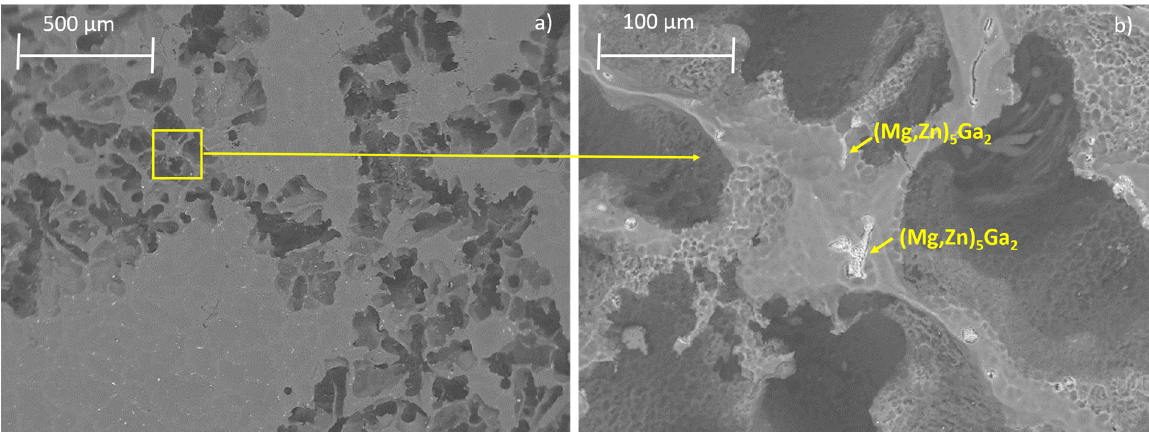
Figure 7. ( a ) Morphology of the as-cast Mg-0.75Ga-3Zn alloy after 168 h of immersion in SBF, after the corrosion products have been removed and ( b ) magnification of the area framed in yellow in Figure 7a.